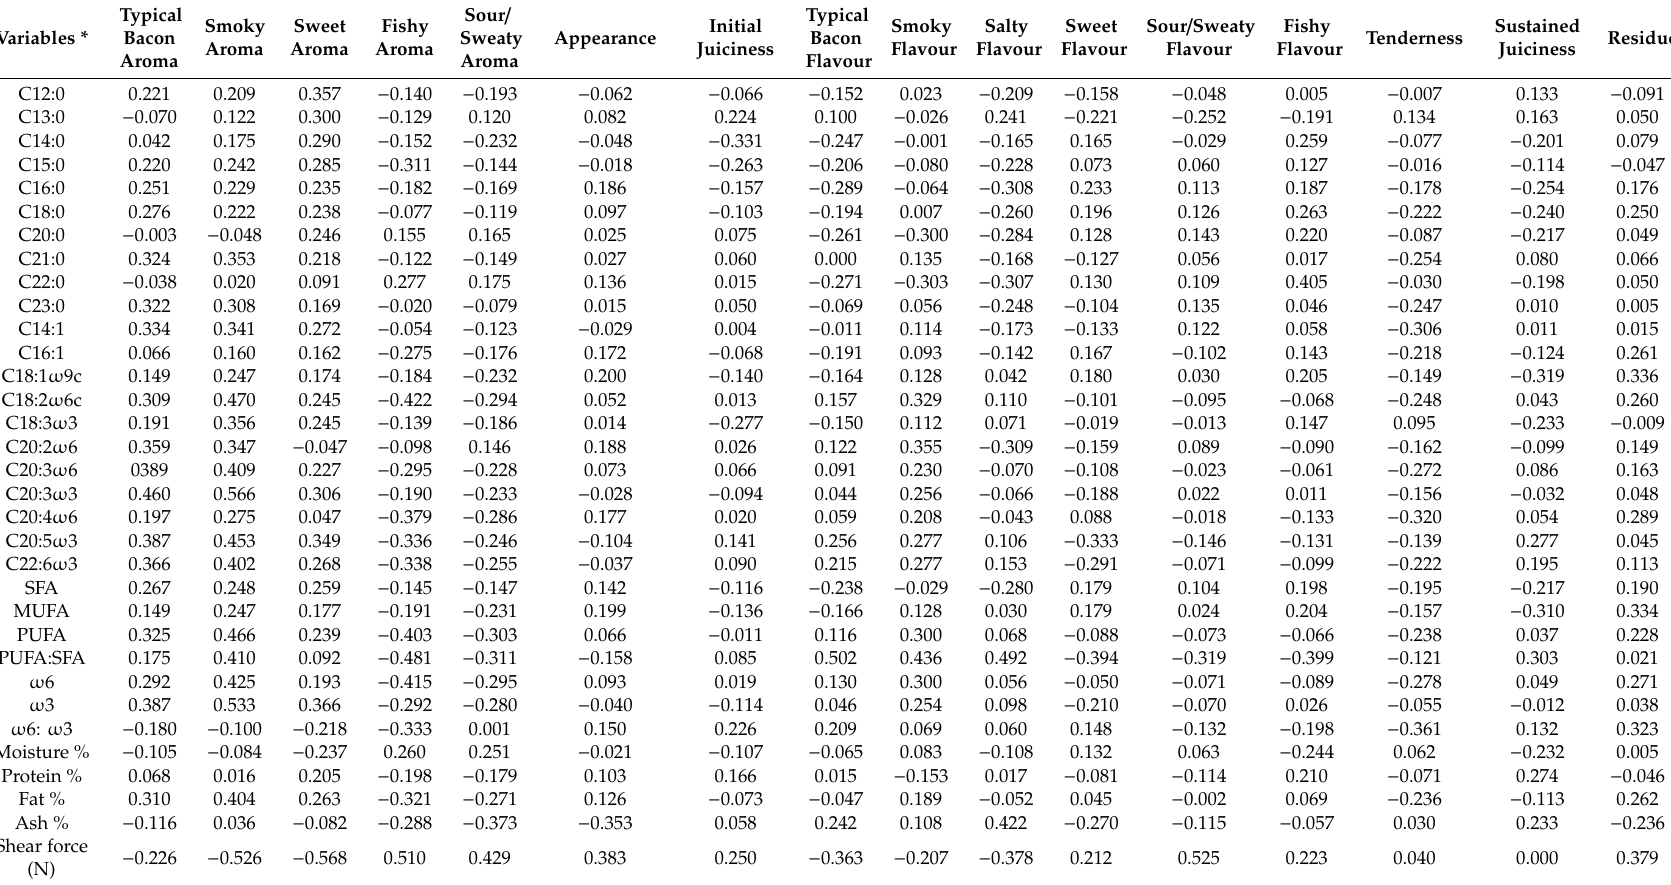
Table 7. Correlation matrix between the sensory attributes, proximate composition and fatty acid composition of warthog back